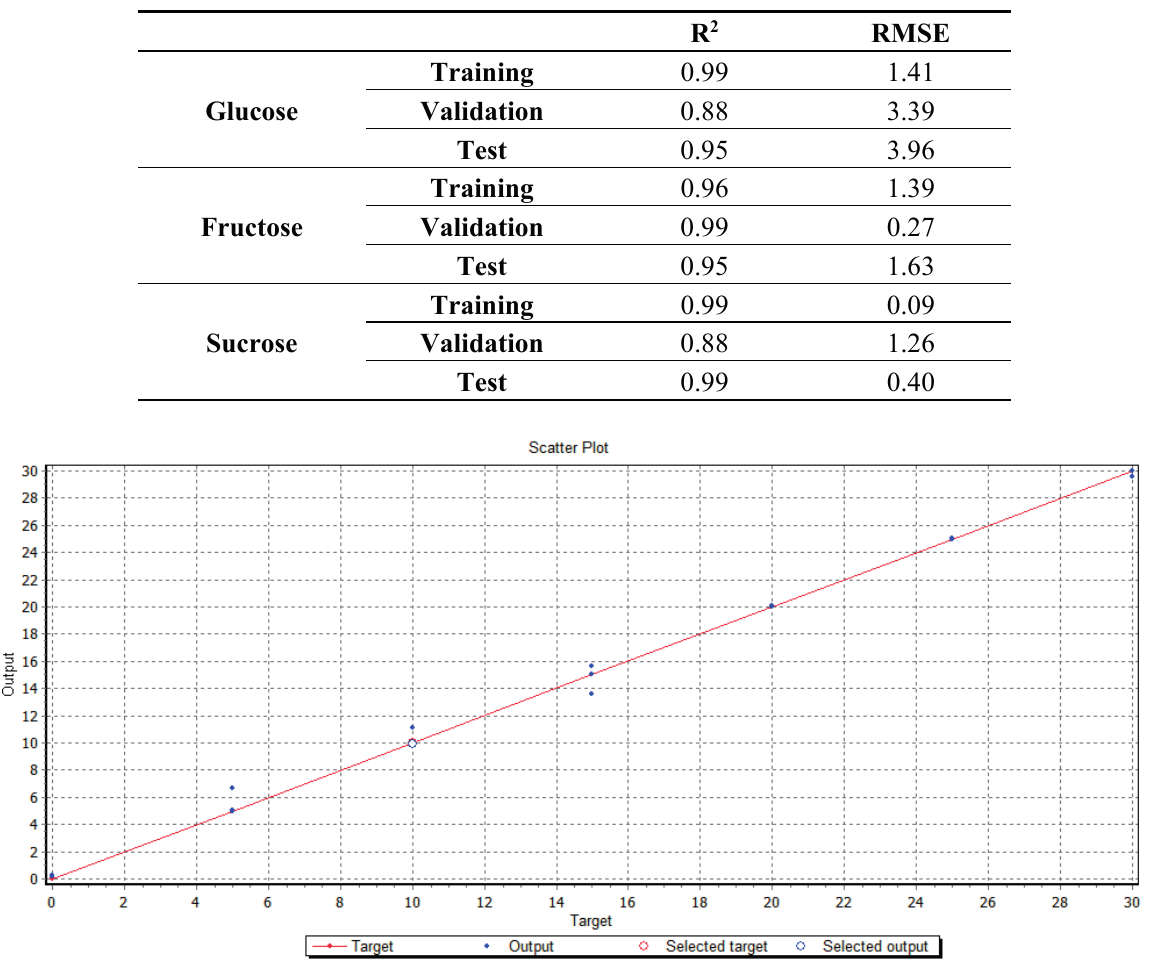
Figure 6. Regression line plot of the obtained ANN model for the studied sucrose concentrations